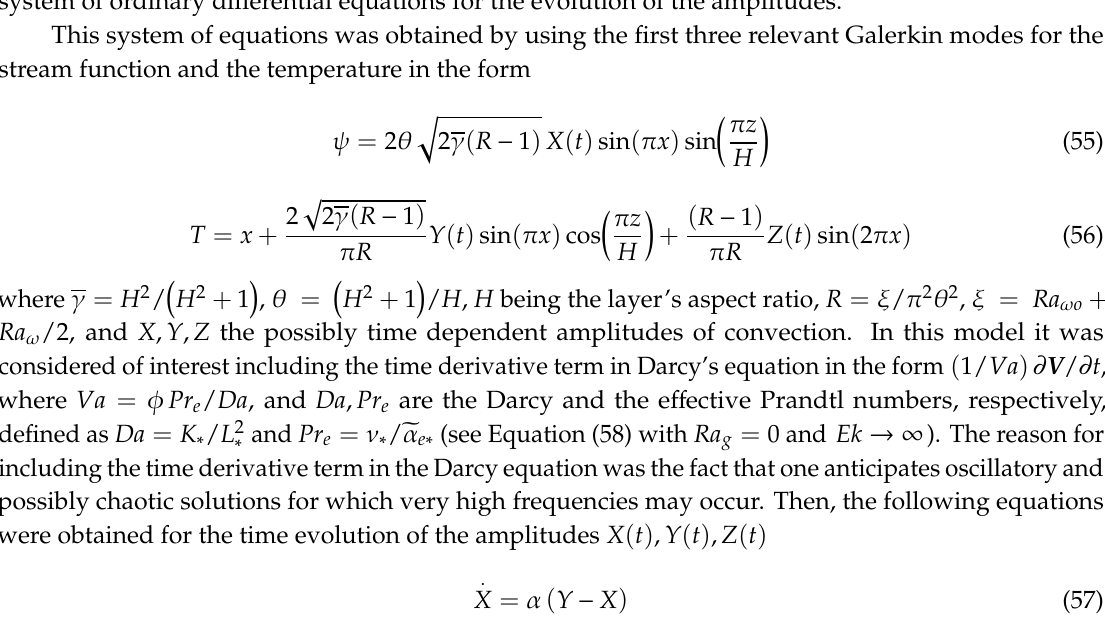
Figure 6. The convective flow field at marginal stability for three different values of x 0 ; 10 stream lines equally divided between ψ min and ψ max . At x 0 = 10 − 10 : ψ min = − 1.378; ψ max = 1.378, at x 0 = 0.02 : ψ min = − 1.374; ψ max = 1.374 and at x 0 = 50 : ψ min = − 1.319; ψ max = 1.319. (Reprinted from [40], with permission from Springer.)